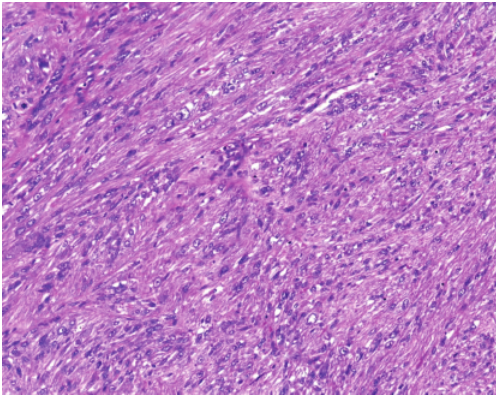
Figure 3: Haematoxylin and eosin section of the tumour under low power field, showing the highly cellular tumour with areas demonstrating smooth muscle di ff